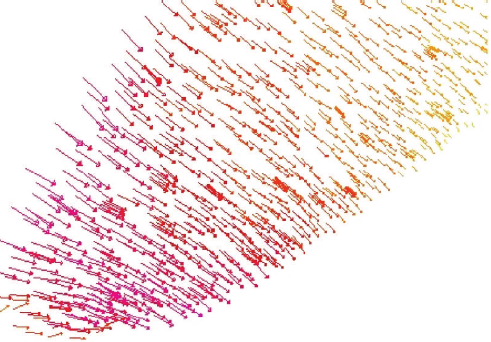
Figure 7: The dynamic transitional vectors of kinetic energy distribution.